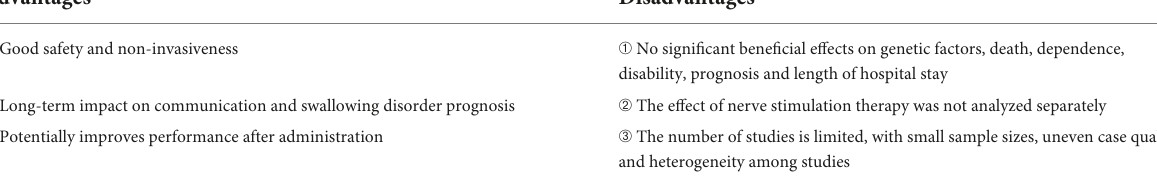
TABLE 2 Advantages and disadvantages of transcranial magnetic stimulation